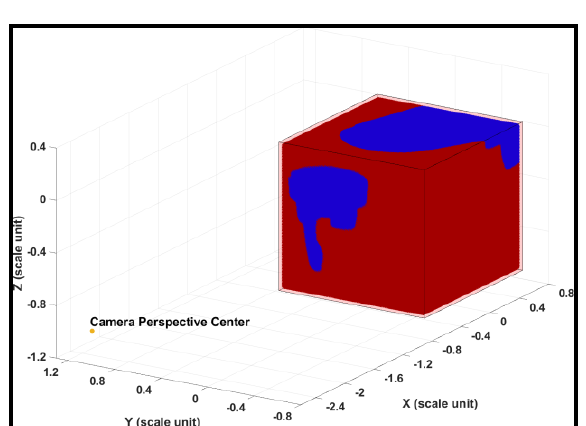
Figure 6. B ack-projected object voxels in the virtual box. Each ray intersects the virtual box at many points. See the entry voxels in the front and some of the exit points on the top and side of the virtual box.